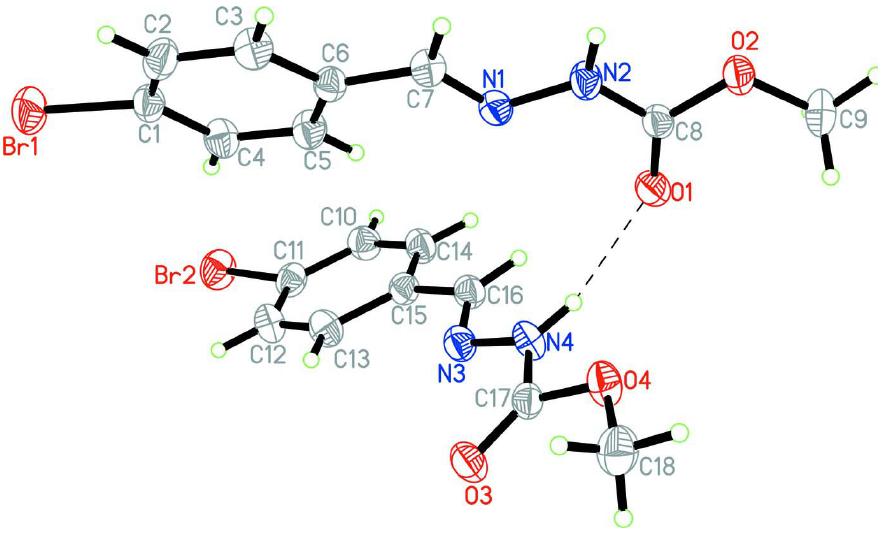
Figure 1 Molecular structure of the title compound, showing 30% probability displacement ellipsoids and the atomic